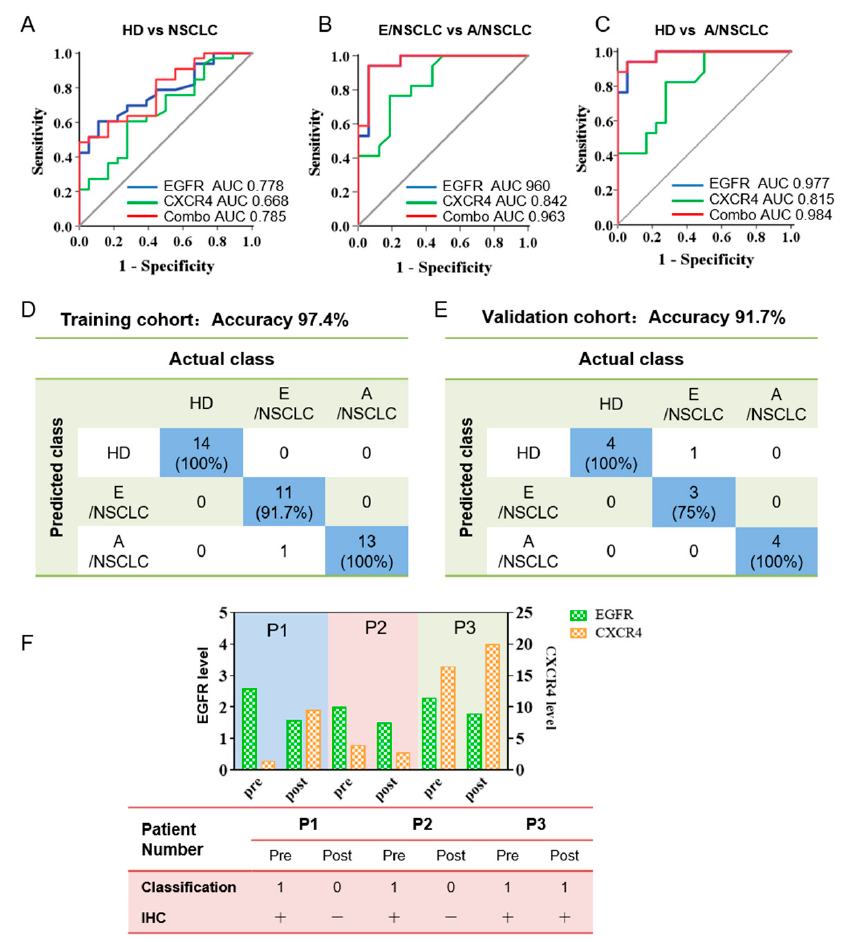
Figure 4. Combined analysis of EGFR and CXCR4 in serum sEVs for the classification of NSCLC by machine learning. ( A – C ) ROC curves showing the discriminative efficacy of EGFR, CXCR4, and the combination of the two markers in differentiating NSCLC patients from HDs ( A ), E/NSCLC from A/NSCLC patients ( B ), and A/NSCLC patients from HDs ( C ). The area under the curve (AUC). ( D , E ) The combination of EGFR and CXCR4 has an accuracy of 97.4% in classifying of HDs, E/NSCLC, and A/NSCLC patients for the training cohort ( D ) and 91.7% for the validation cohort ( E ) by machine learning. The data in blue boxes are the number and percentage of the truly predicted results. ( F ) Prognostic significance of serum sEVs for NSCLC progression. Upper: histogram showing the expression of EGFR and CXCR4 in serum sEVs from three stage I NSCLC patients before and three days after surgery. Lower: machine learning-based predictive classification and IHC-based validation of the prognosis of the NSCLC patients. Machine learning classification was according to the expression of EGFR and CXCR4 on serum sEVs before and three days after surgery. IHC validation was performed six months after surgery. In patient #3 who was classified as class 1 (patient class) three days after surgery by machine learning, multiple small pulmonary nodules were observed six months after surgery, indicating a prediction accuracy of